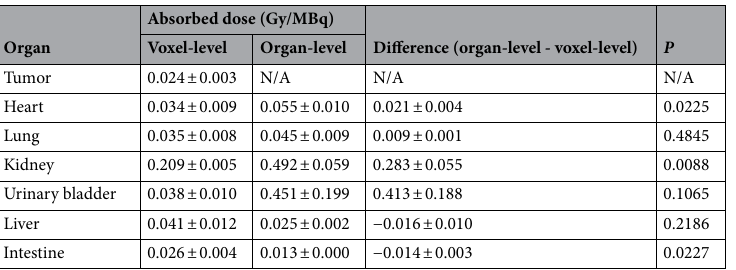
Table 2. Absorbed dose received by organs of the subcutaneous prostate cancer xenograft model mice after [ 68 Ga]PSMA-11 administration. Values are the mean ± SEM ( n = 3).